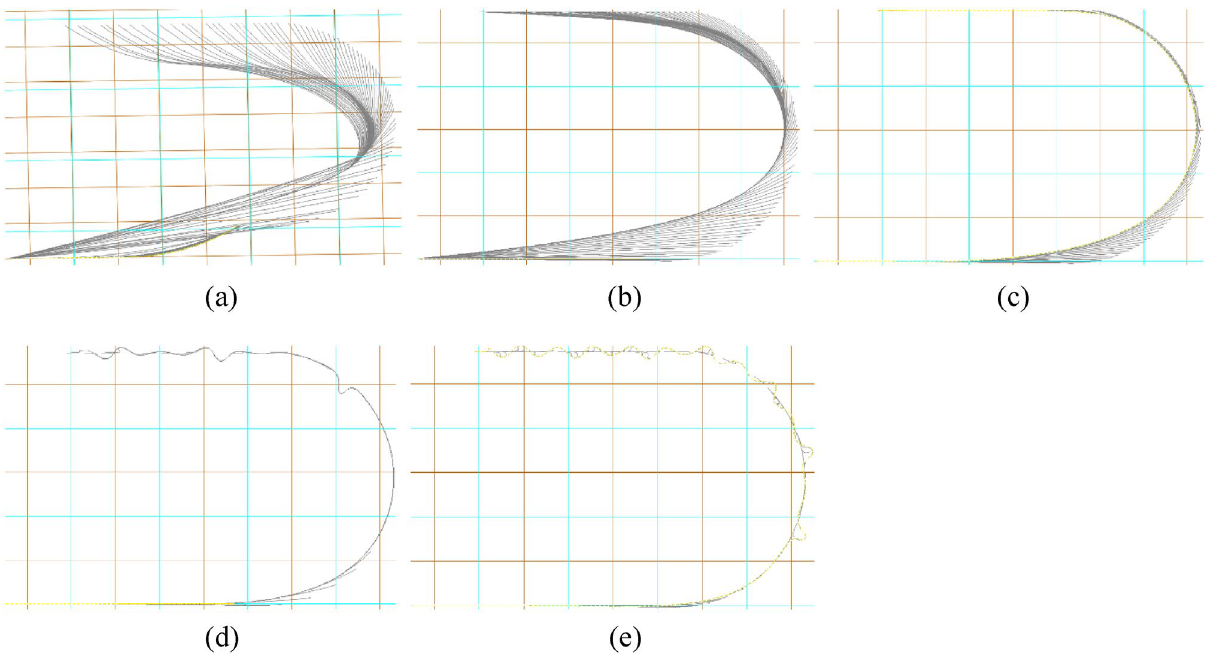
Figure 5. Configurations of marine cable at top view at different release rates during turning process: ( a ) 0.8 m/s; ( b ) 0.9 m/s; ( c ) 1.0 m/s; ( d ) 1.1 m/s; ( e ) 1.2